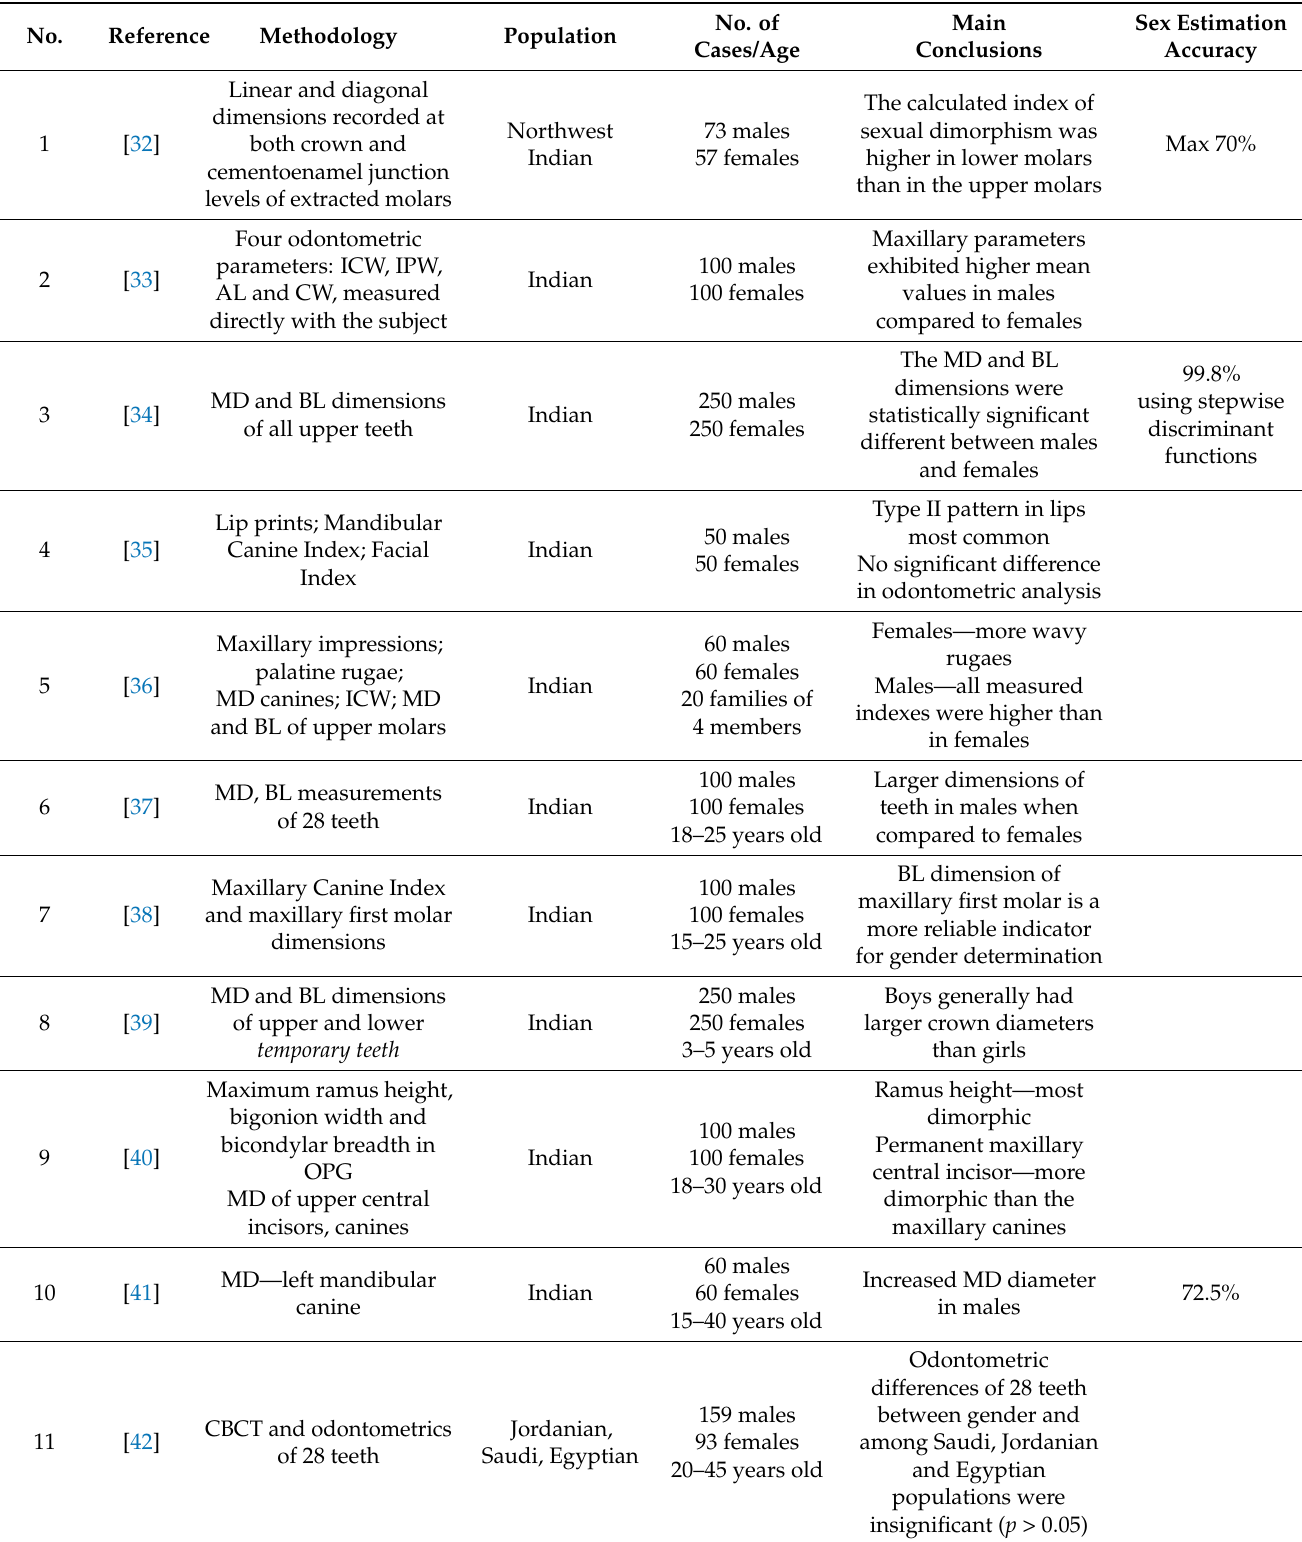
Table 1. Odontometric